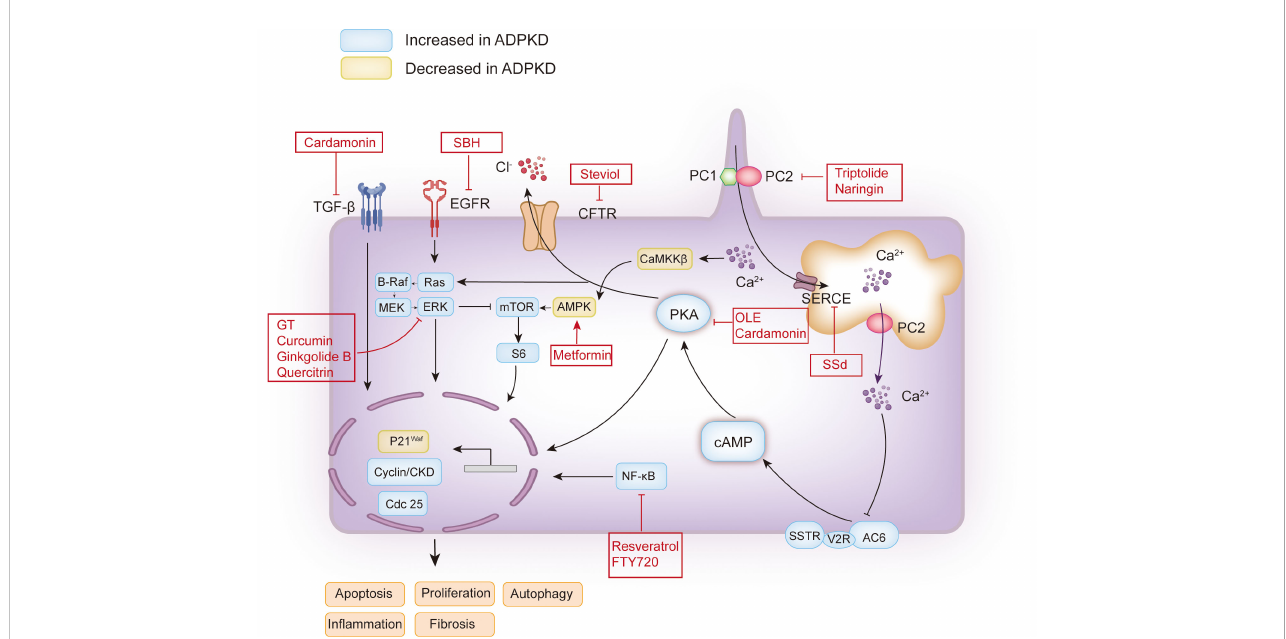
FIGURE 1 Schematic map of the pathogenesis of ADPKD and the therapeutic targets of plant extracts or plant-derived compounds. The functional site of PC1 and PC2 associated with polycystic kidney disease is on the cilia. The decrease or loss of PC1 or PC2 caused by PKD1 and PKD2 mutations may lead to a decrease in intracellular calcium concentration or an increase in intracellular cAMP. The increase of cAMP will activate PKA, which will activate the mTOR, Ras, and other signaling pathways, and promote cell proliferation. Activated PKA can also promote Cl - to enter the cyst cavity through CFTR, thus promoting the secretion of cyst fl uid. In addition, EGFR can promote cell proliferation by activating Ras. Additionally, calcium ions can induce autophagy by activating CaMKK b -AMPK-mTOR. The red boxes contain the candidate plant extracts or plant-derived compounds. PC1, polycystin-1; PC2, polycystin-2; AC6, adenylyl cyclase six; V2R, vasopressin type 2 receptor; SSTR, somatostatin receptor; cAMP, cyclic adenosine monophosphate; PKA, protein kinase A; CFTR, cystic fi brosis transmembrane conductance regulator; EGFR, epidermal growth factor receptor; MEK, mitogen-activated protein kinase; ERK, extracellular-signal-regulated kinase; mTOR, the mammalian target of rapamycin; SERCA, sarcoplasmic/endoplasmic reticulum Ca 2+ ATPase; CaMKK b , Ca 2+ /CaM-dependent protein kinase b ; AMPK, AMP-activated protein kinase; TGF- b , transforming growth factor- b ; SSd, saikosaponin- d; GT, Ganoderma triterpenes; SBH, Sparganum stoloniferum